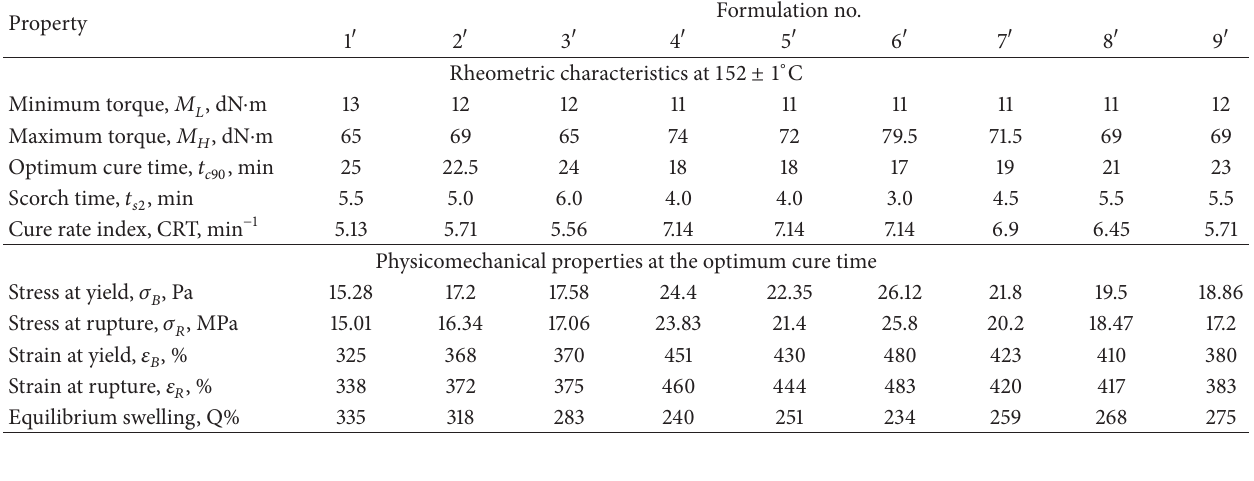
Table 4: Rheometric characteristics and physico-mechanical properties of SBR vulcanizates containing the prepared homopolymers and copolymers.